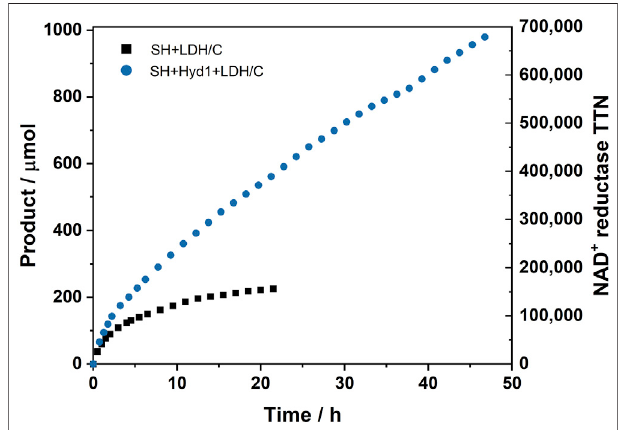
FIGURE 8 | Lifetime performance of SH + LDH/C [SH (0.25 mg), LDH (3 mg), activated charcoal (30 mg)] vs. SH + Hyd1+LDH/C [SH (0.25 mg), Hyd1 (0.2 mg), LDH (3 mg), activated charcoal (30 mg)] for the conversion of pyruvate to lactate in the hydrogenation fl ow reactor. The cumulative amount of product formed is shown on the left y axis. The TTN of the NAD + reductase module of the SH is shown on the right y axis. Reaction conditions: pyruvate(20 mM),NAD + (1 mM),Tris-HClbuffer (50 mM, pH8.0),30 ° C,liquid fl ow rate (cid:1) 0.05 – 0.1 ml min − 1 , H fl ow rate (cid:1) 0.6 – 1.2 ml min − 1 , t (cid:1) 9 – 18 s, 2 Res reactor volume (cid:1) 0.2 ml.